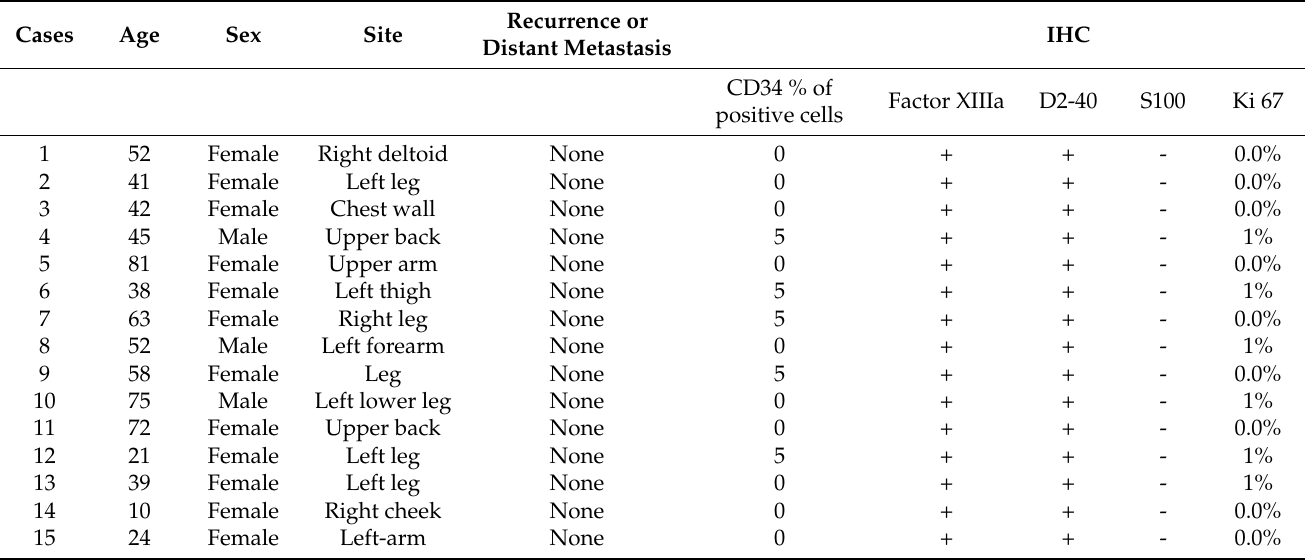
Table 4. CD34- negative dermatofibromas (the control group in the current